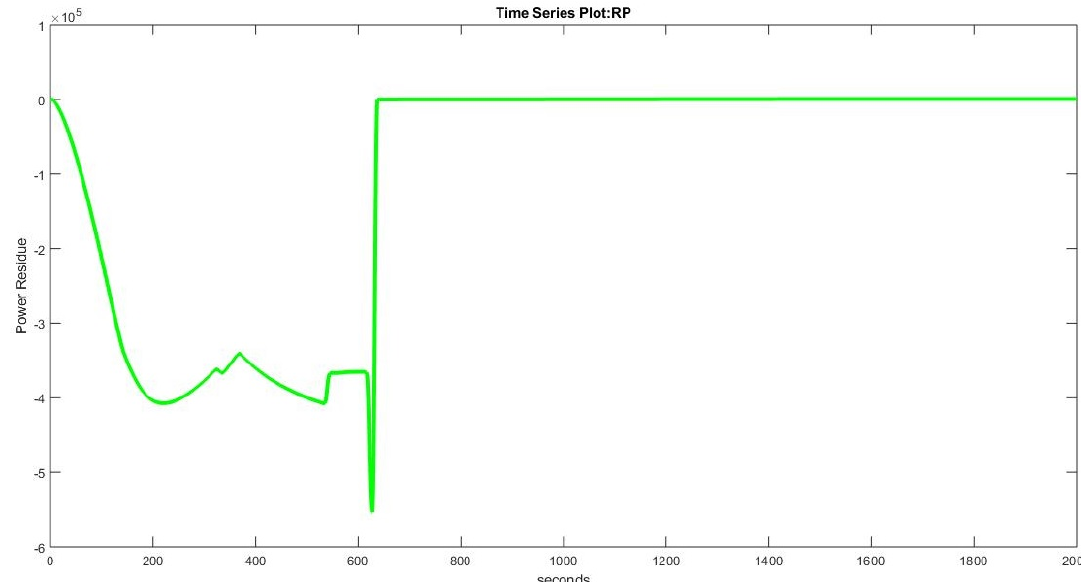
Figure 14. Power residue for the saturation and leakage fault of sluice gate w 1 .